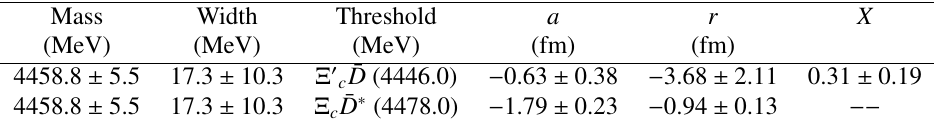
Table 7. Results of the P cs (4459) for a , r and X from the ERE method. The relevant channel is indicated in the third